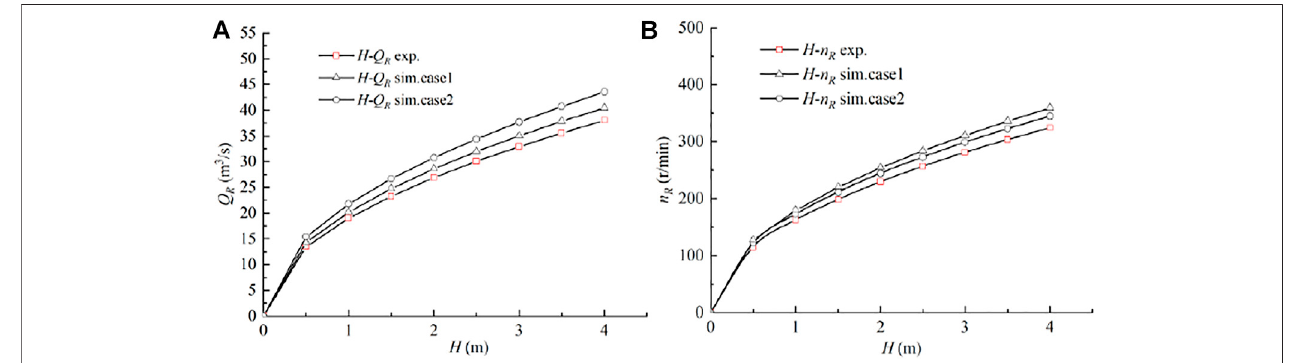
FIGURE 7 | Comparison of the runaway rotation speeds (A) and fl ow rates (B) under different heads.